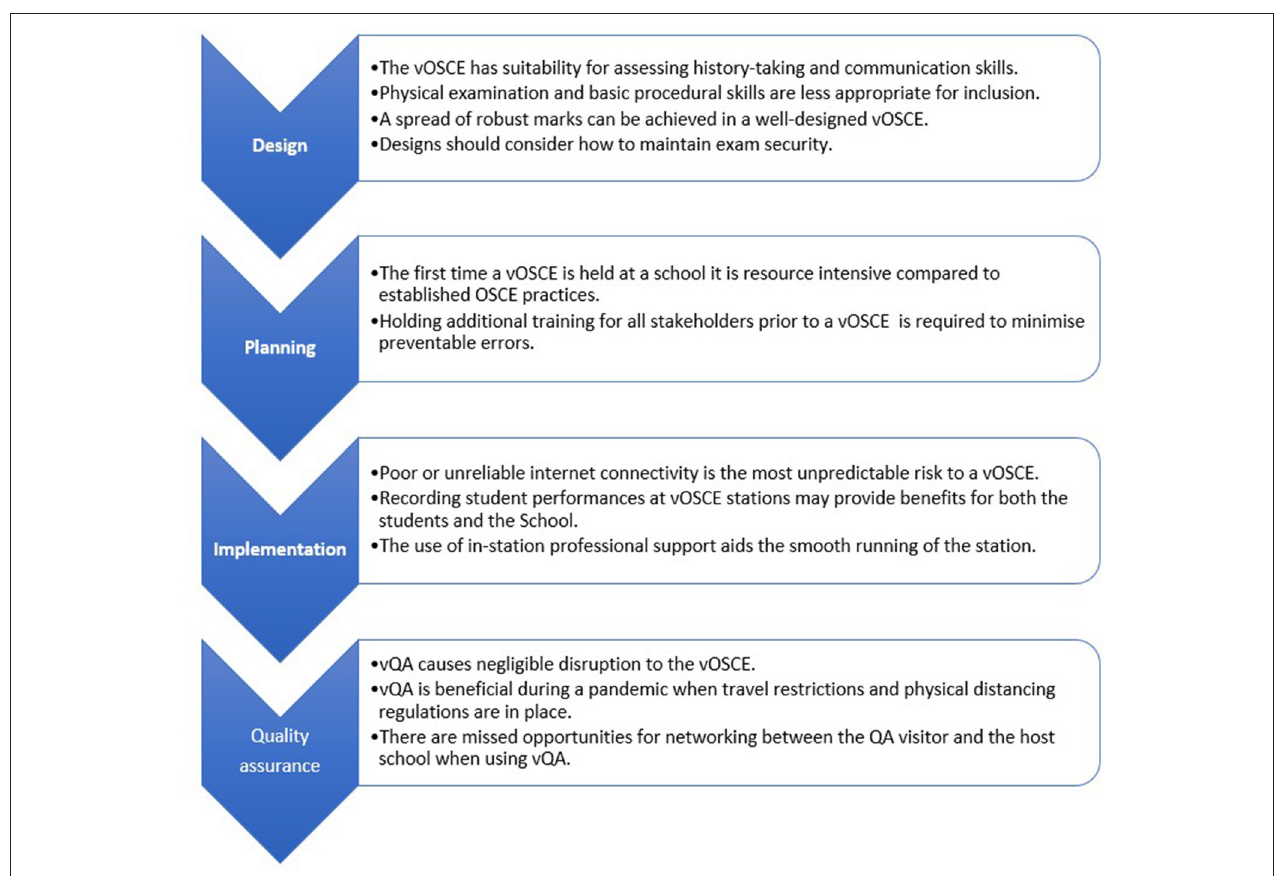
FIGURE 1 | vOSCE 2020 lessons